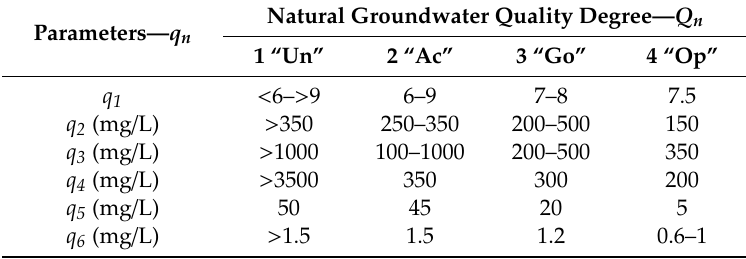
Table 3. Natural groundwater quality pattern matrix ( Z q ). Un—unfit; Ac—acceptable; Go—good;